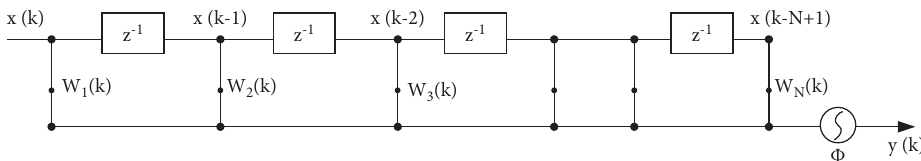
Figure 6: RNN simulation of nonlinear adaptive system